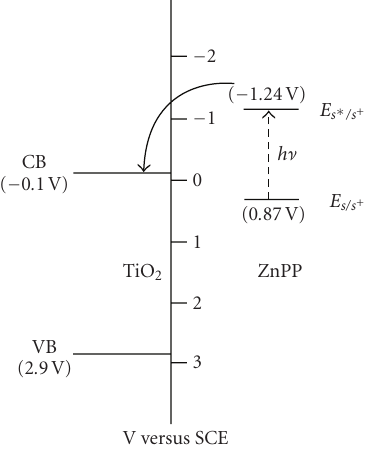
Scheme 3: Schematic energy level diagram showing electron transfer process.